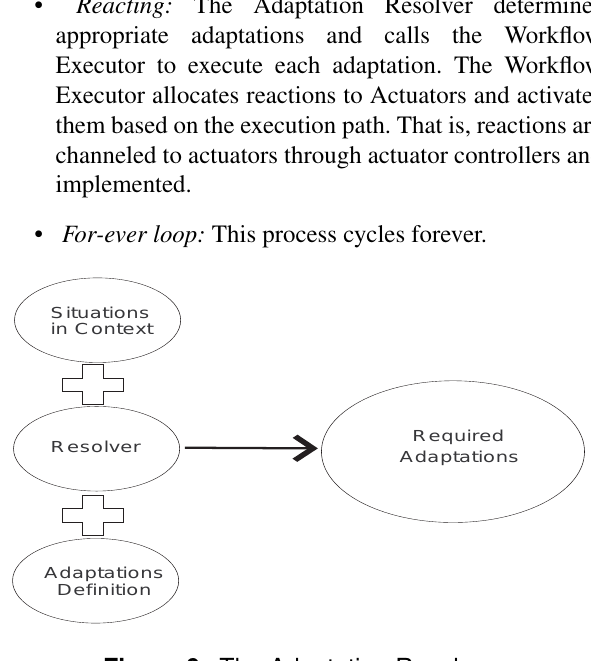
Figure 9. The Adaptation